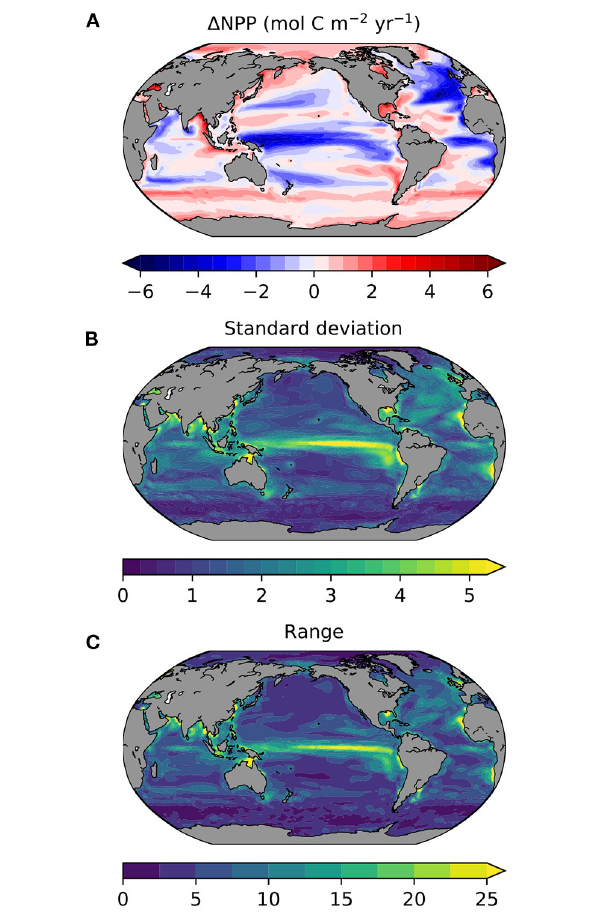
FIGURE 4 | The SSP5-8.5 change in NPP from 16 CMIP6 models by 2081-2100 (relative to 1995–2014) for (A) multi-model mean, (B) 1 σ , and (C) the full inter-model range. All plots show annual NPP in mol C m − 2 yr − 1 . Note scale change for (C)